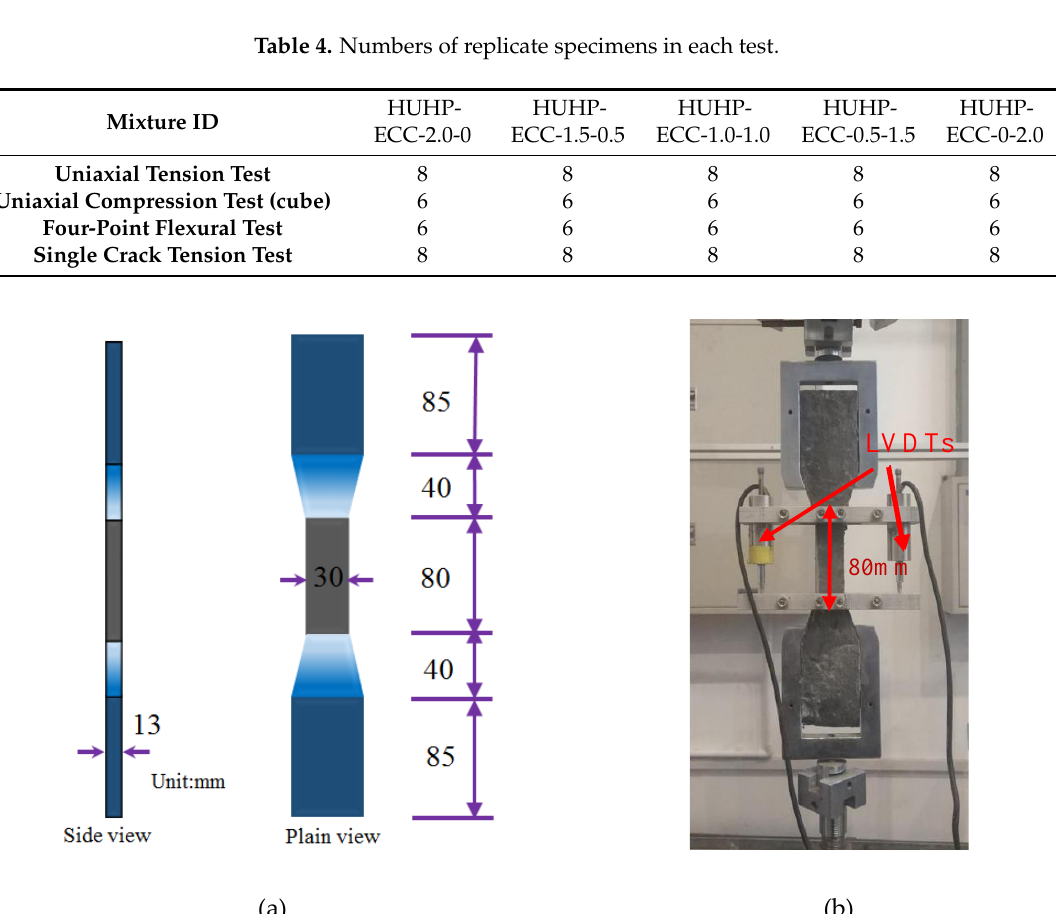
Figure 2. Dogbone specimen for engineered cementitious composite (ECC) tensile test. ( a ) Dimension of dog bone specimen; ( b ) Test setup.